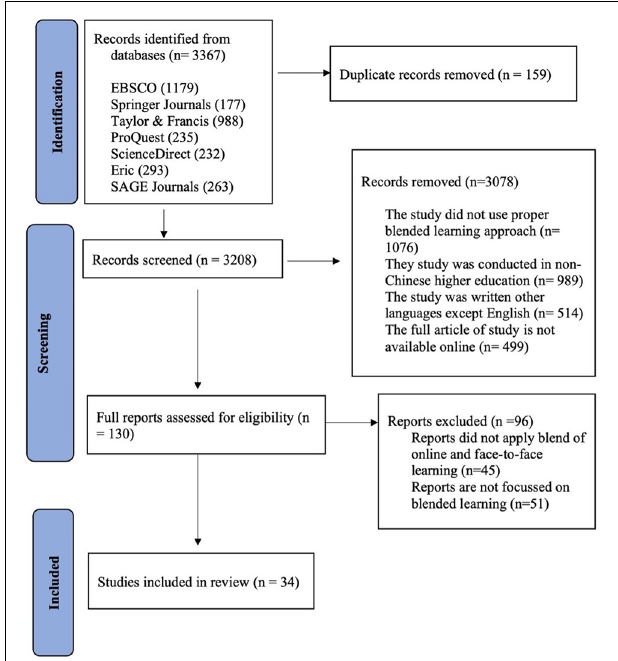
FIGURE 1 | Flowchart of the systematic search of the